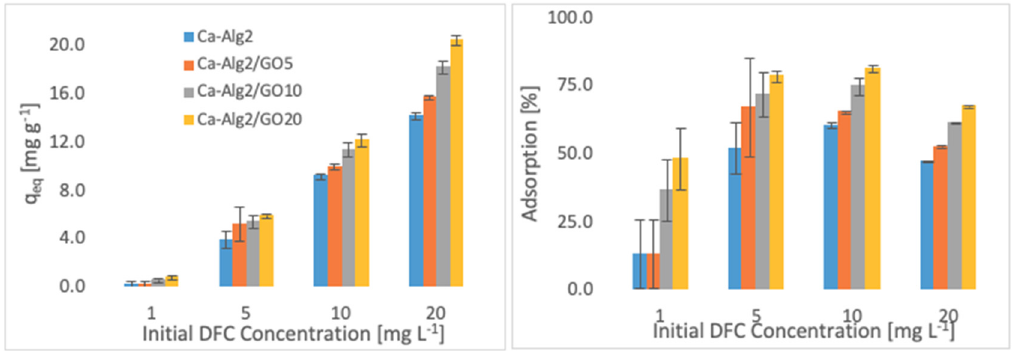
Figure 5. Effect of the initial concentration of FMTD on q eq and adsorption percentage.